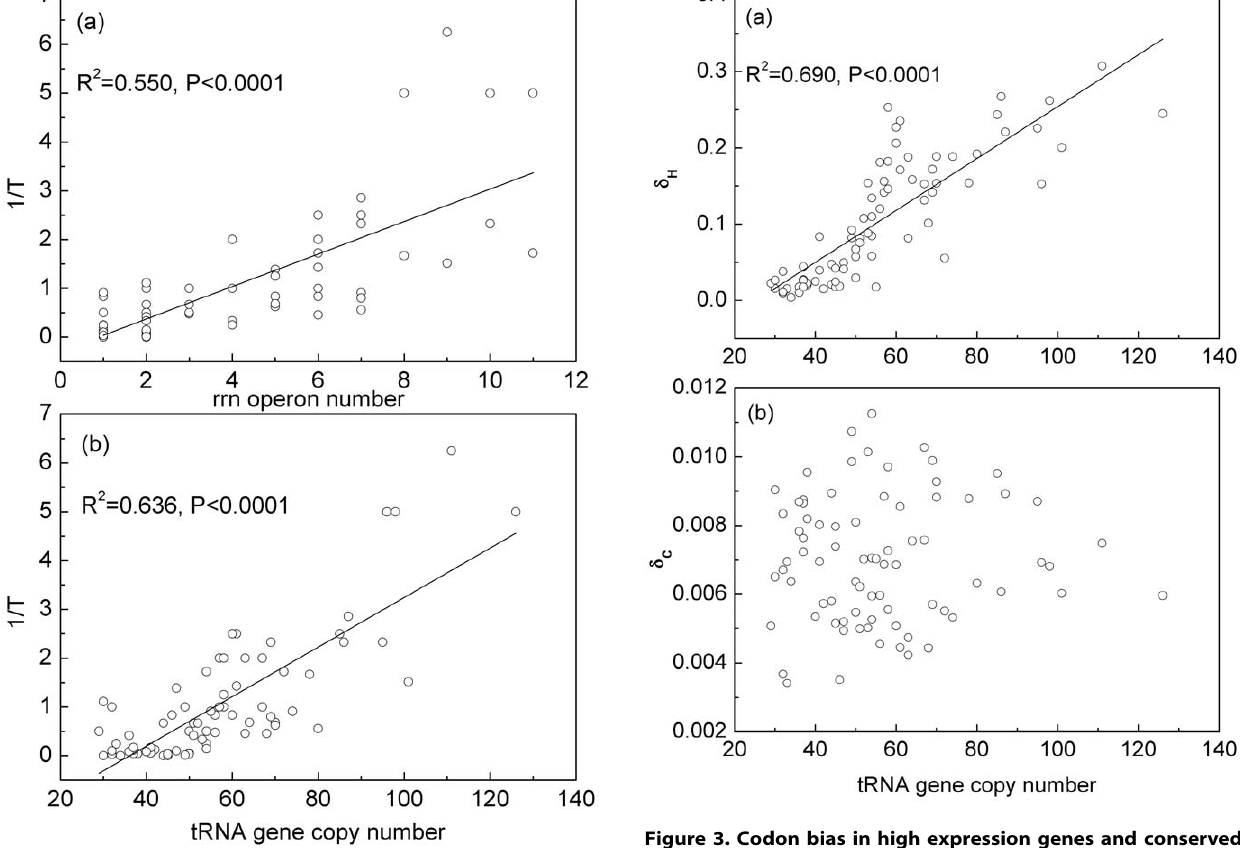
Figure 2. Bacteria growth rate. Growth rate, shown as the inverse of the minimum doubling time, 1/T (hours 2 1 ), is strongly correlated with the number of copies of (a) ribosomal RNA operons, and (b) tRNA genes.